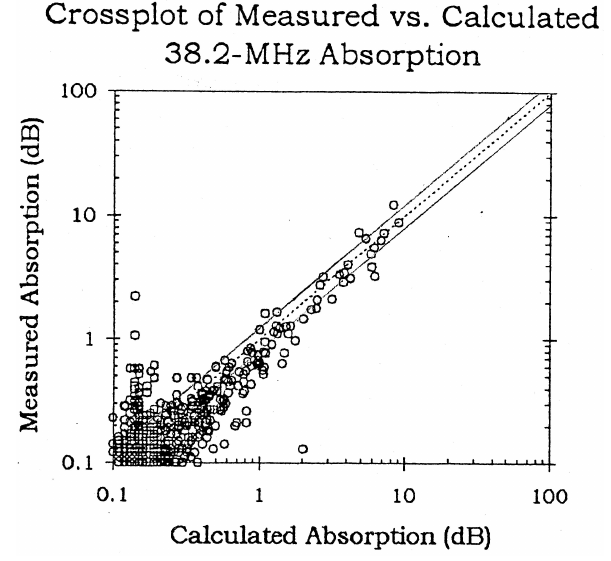
Fig. 2. Comparison between measured and calculated absorption during PCAs (Patterson et al., 2001). The outer lines indicate a difference of 20%. √ Height (km) Production rate Combined coeff. Absorption